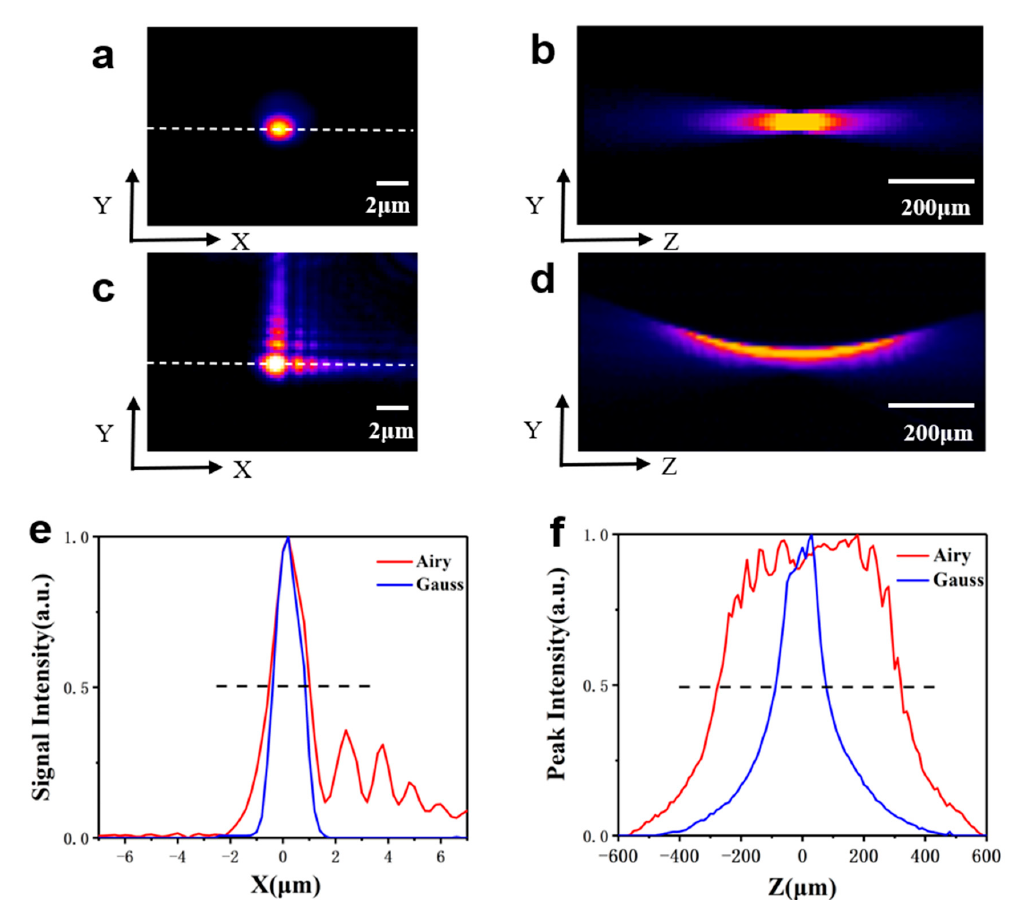
Figure 2. Images of Gaussian (top) and Airy (middle) spot shapes in free space with 633 nm laser. ( a ) and ( b ) are lateral and axial images in the Gaussian mode, respectively; ( c ) and ( d ) are lateral and axial images in the Airy mode, respectively; ( e ) Intensity profiles in lateral images marked with white dotted lines in ( a ) and ( c ); ( f ) Maximum signal intensity along the axial direction for ( b ) and ( d ). Red lines indicate the Airy beam, blue lines stand for the Gaussian beam. Both signal intensities of the Airy beam and Gaussian beam are